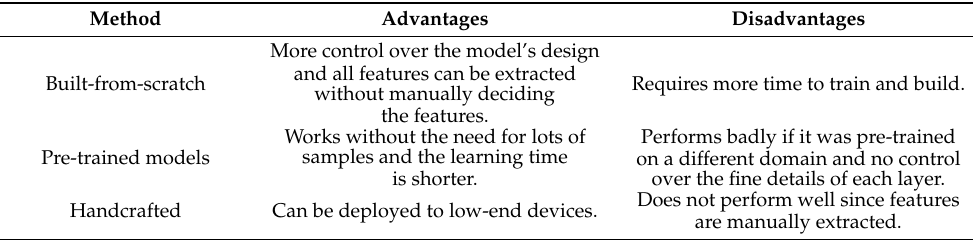
Table 2. Comparison of the different methods of build age estimation